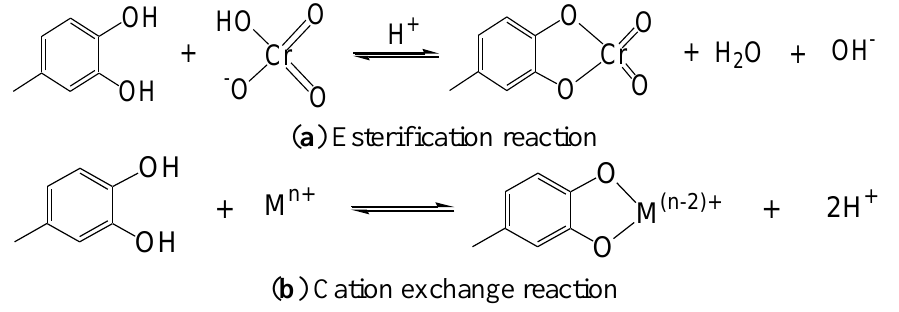
Scheme 2. The binding mechanism of ( a ) chromium(VI) and ( b ) other metals to the hydroxyl groups of catechol units on the cross-linked persimmon